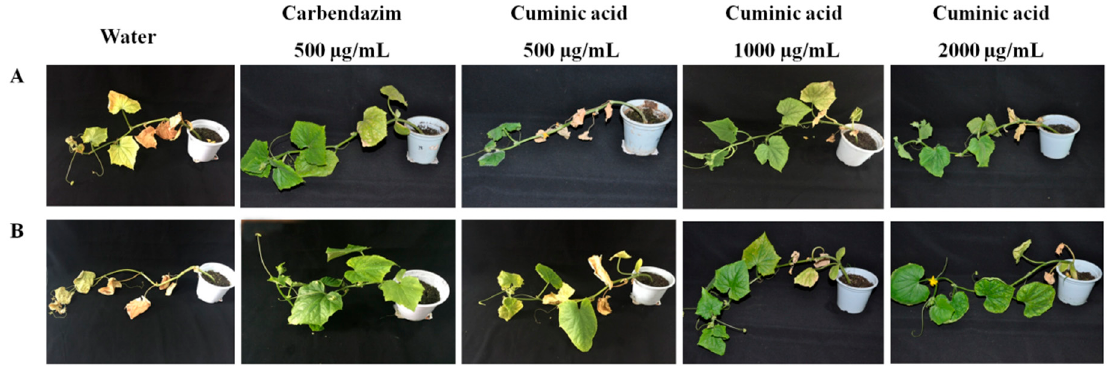
Figure 1. ( A ) Protective and ( B ) curative activity of cuminic acid against F. oxysporum .